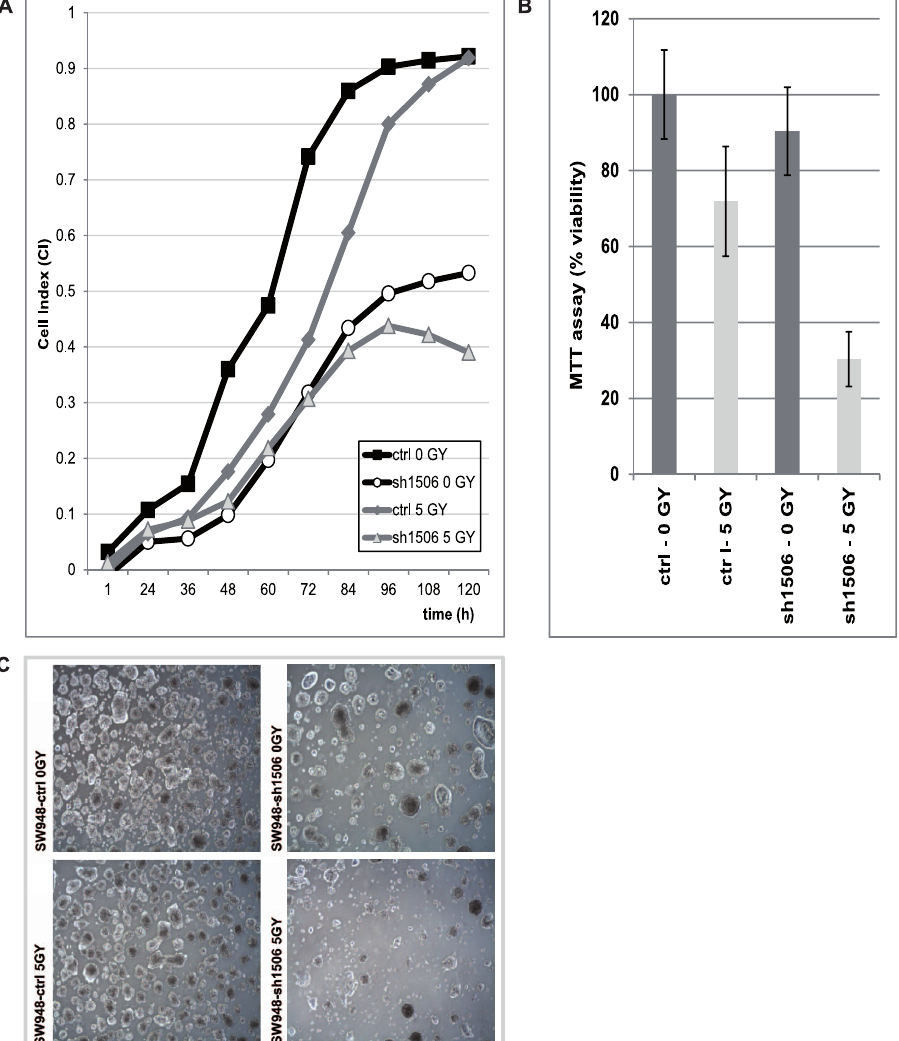
Figure 5. Irradiation of colon cancer cells. A) SW948-ctrl or SW948-sh1506 with stable KRT23 knockdown were irradiated with 0 GY or 5 GY of c - rays, respectively and seeded on RTCA16-well plates with 16.000 cells/well (n=4). Non-irradiated SW948-sh1506 cells showed a reduced proliferation rate compared to non-irradiated SW948-ctrl cells. Irradiated SW948-ctrl cells continued proliferation after a short lag period, while the proliferation of the irradiated KRT23-depleted SW948-sh1506 cells decreased after 72 h post-irradiation. The Cell Index CI of the irradiated SW948-sh1506 cells markedly dropped down at about 96 h post-irradiation suggesting a detaching of the cells, possibly induced by cell death upon irradiation of the KRT23 depleted cells. B) A MTT viability assay co-performed at 120 h post-irradiation together with RTCA showed that the viability of KRT23 depleted SW948-sh1506 cells was reduced by 60% upon irradiation with 5GY (p=8.1E-08) compared to 30% in the SW948-ctrl cells (p=6.4E-05). C) Visual inspection at 7 days post-irradiation showed a markedly reduced number of cells in KRT23 depleted SW948-sh1506 cells irradiated with 5GY compared to non-irradiated cells.